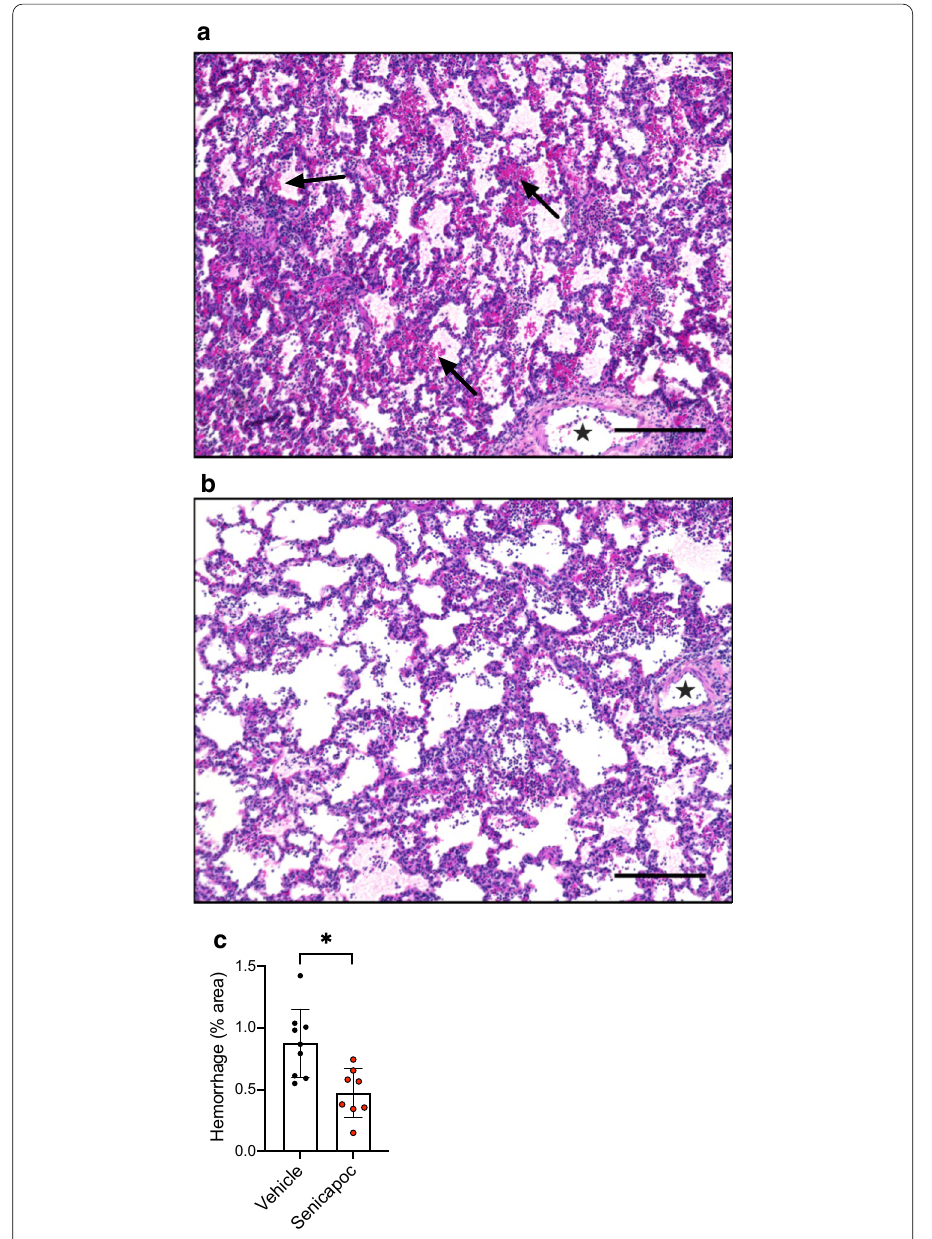
Fig. 6 Senicapoc reduces histological pulmonary hemorrhage. Representative picture of a vehicle and b senicapoc. c Summary of interstitial and alveolar hemorrhage. Hemorrhage is indicated by black arrows. Note the absence of perivascular cuffs (filled star). Data are presented as mean SD. * P < 0.05 for senicapoc against ± vehicle. Vehicle, n 9 and senicapoc, n 8. The scale in picture A and B indicates 200 = =